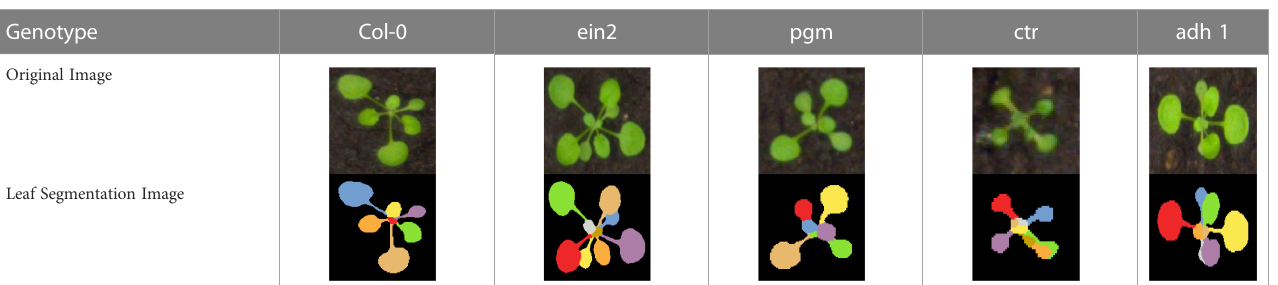
TABLE 1 Sample image of the Ara2013-Canon